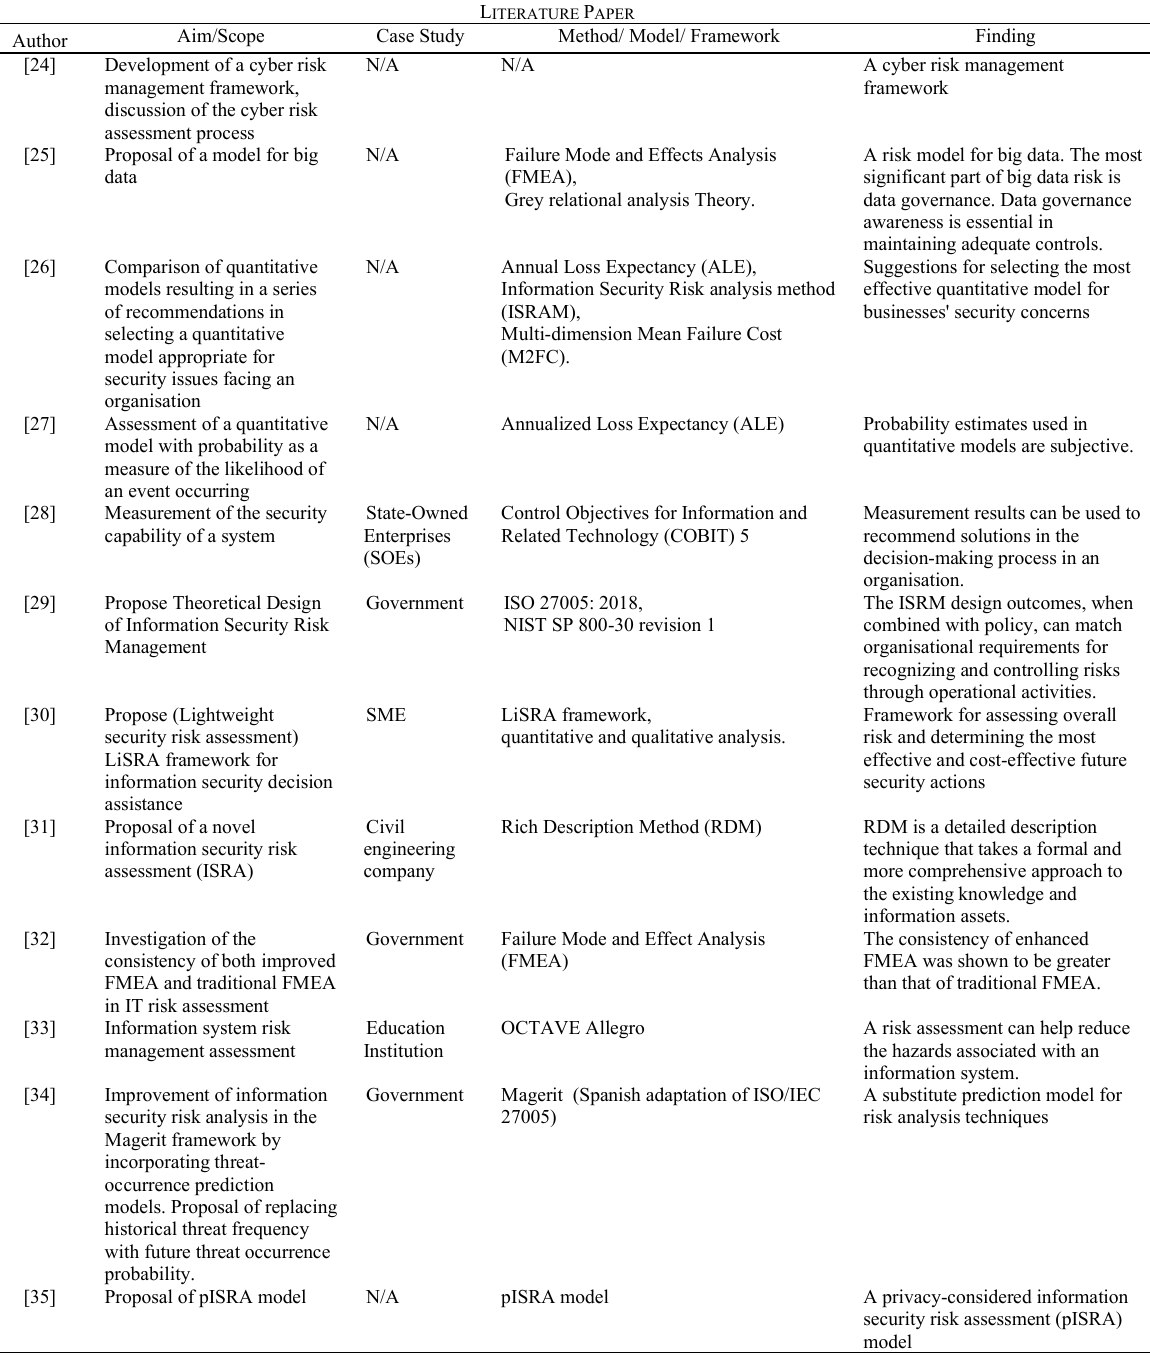
TABLE 1 (cont.) L ITERATURE P